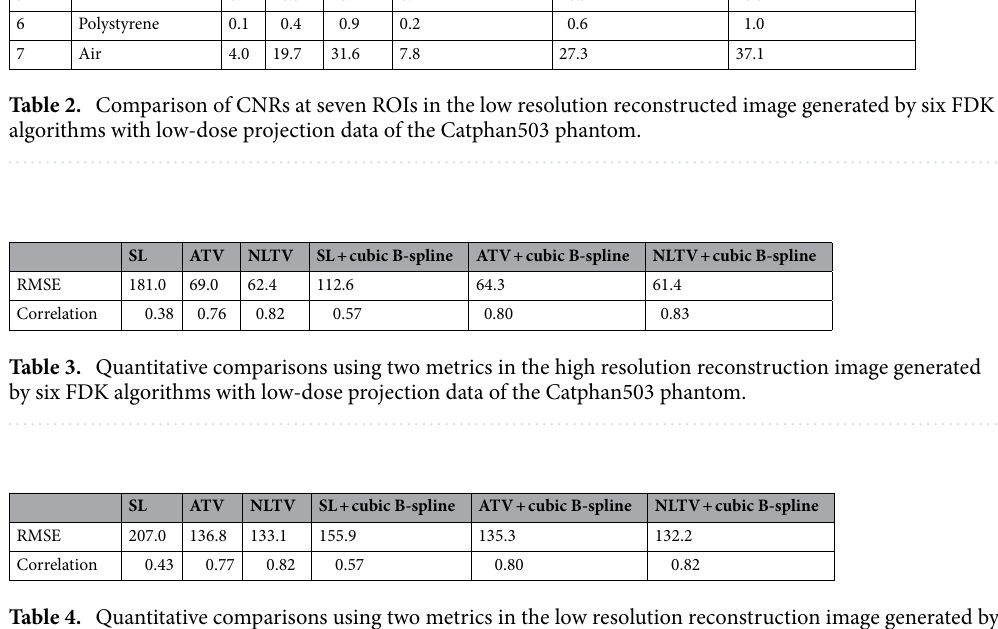
Table 4. Quantitative comparisons using two metrics in the low resolution reconstruction image generated by six FDK algorithms with low-dose projection data of the Catphan503 phantom.